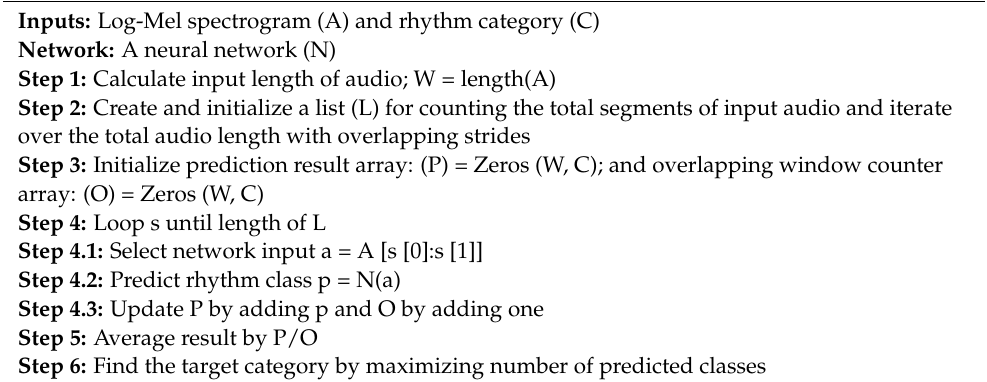
Algorithm 1: Classification-based segmentation with overlapped sliding windows